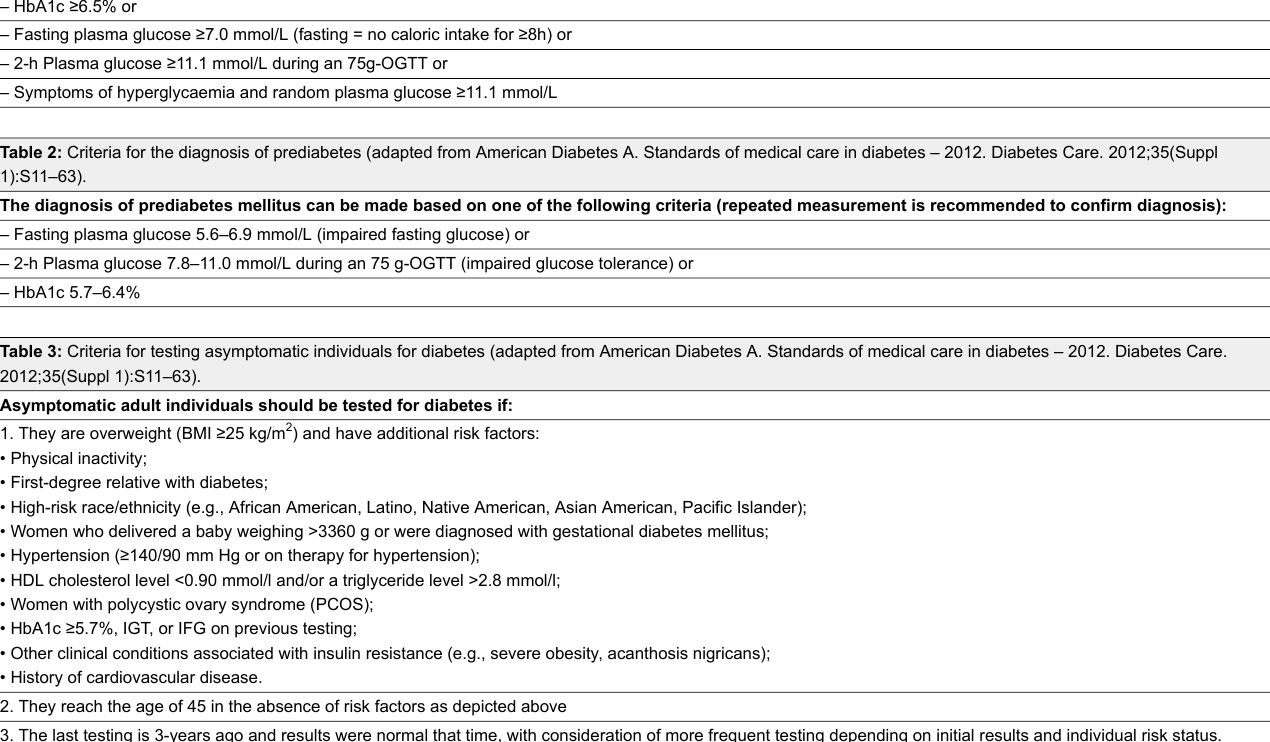
Table 1: Criteria for the diagnosis of diabetes (adapted from American Diabetes A. Standards of medical care in diabetes – 2012. Diabetes Care. 2012;35(Suppl 1):S11–63). The diagnosis of diabetes mellitus can be made based on one of the following criteria (repeated measurement is recommended to confirm diagnosis):